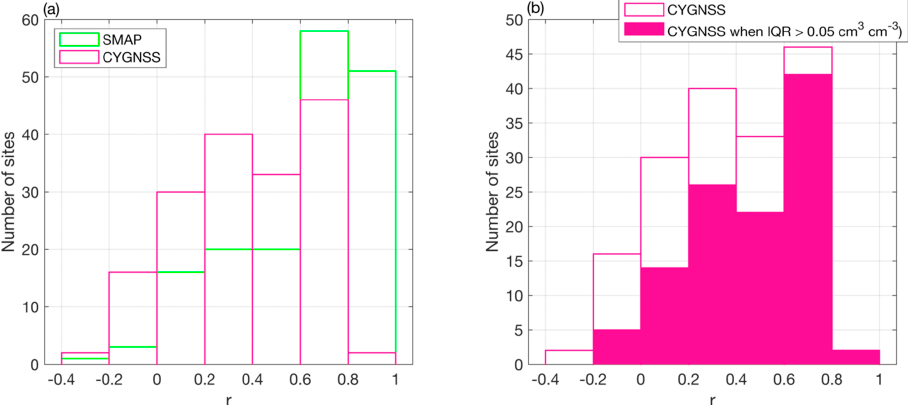
Figure 10. ( a ) Distributions of the correlation coefficient (r) between CYGNSS and in-situ observations (pink bars) and SMAP and in-situ observations (green bars). ( b ) The distribution of the correlation coefficient between CYGNSS and in-situ observations (open pink bars, same as in (a)) and the distribution of the correlation coefficient when only in-situ sites with moderate to high soil moisture variability are considered (closed pink bars).